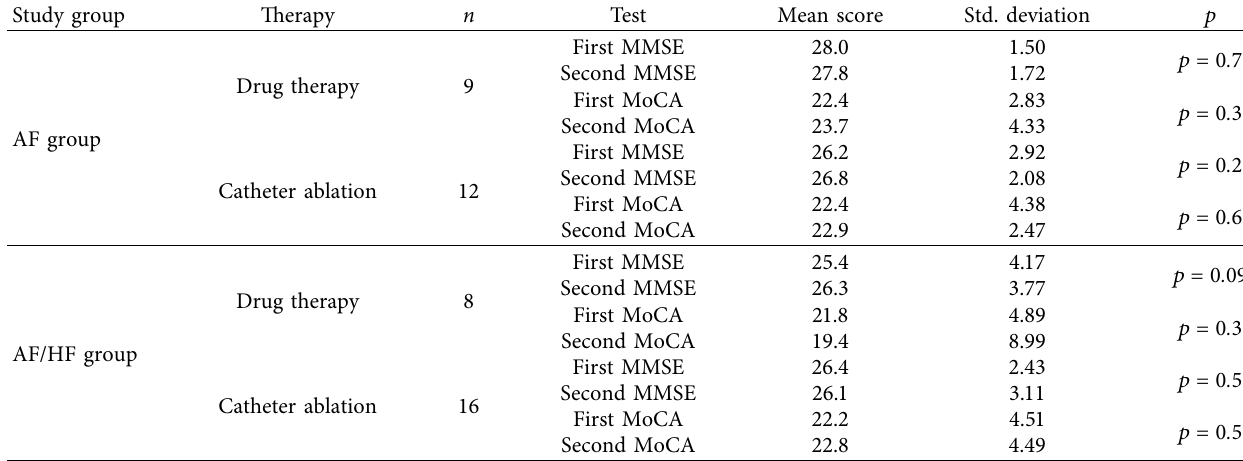
Table 2: Results of the study group in twice performed Mini-Mental State Examination and Montreal Cognitive Assessment tool with an intertest interval of 6 months. Study